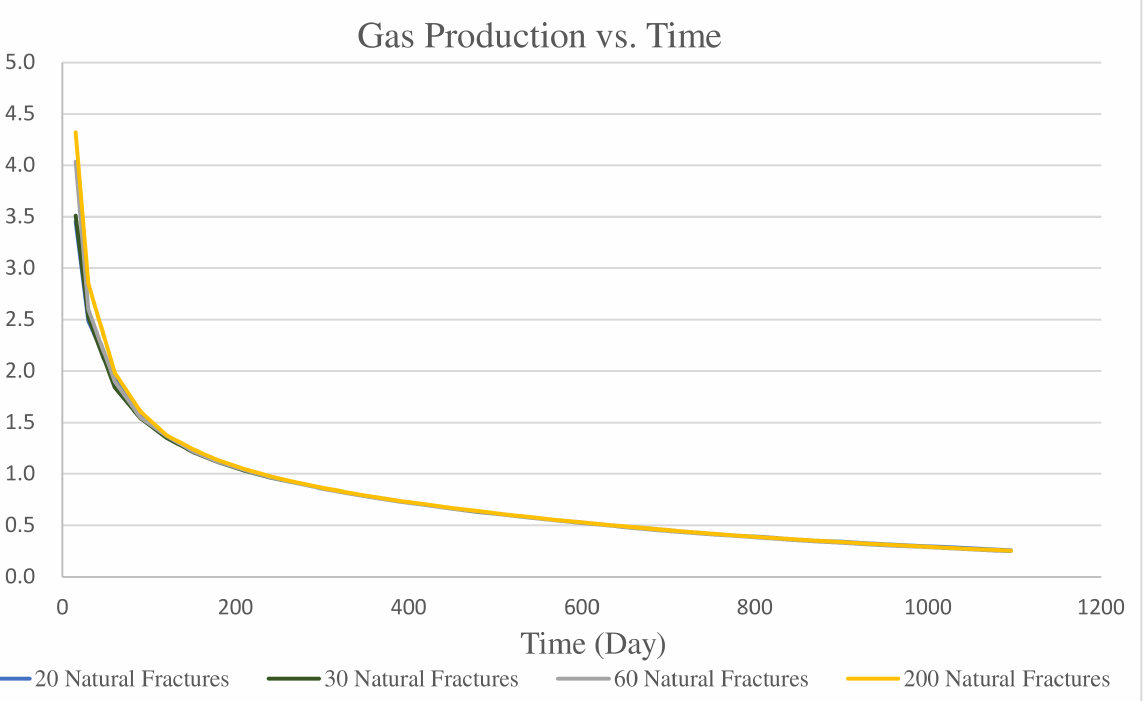
Figure 8. Simulated gas production with different numbers of natural